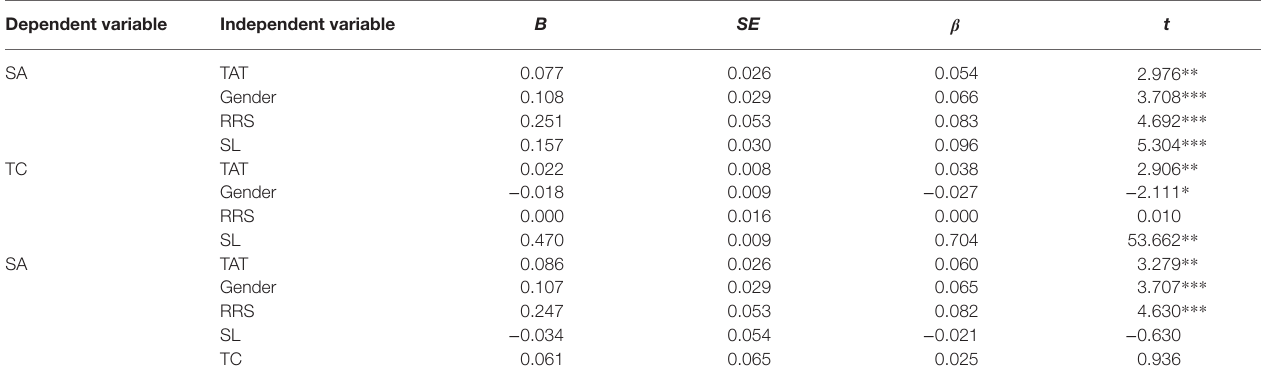
TABLE 2 | Hierarchical regression analyses predicting student achievement (SA). Dependent